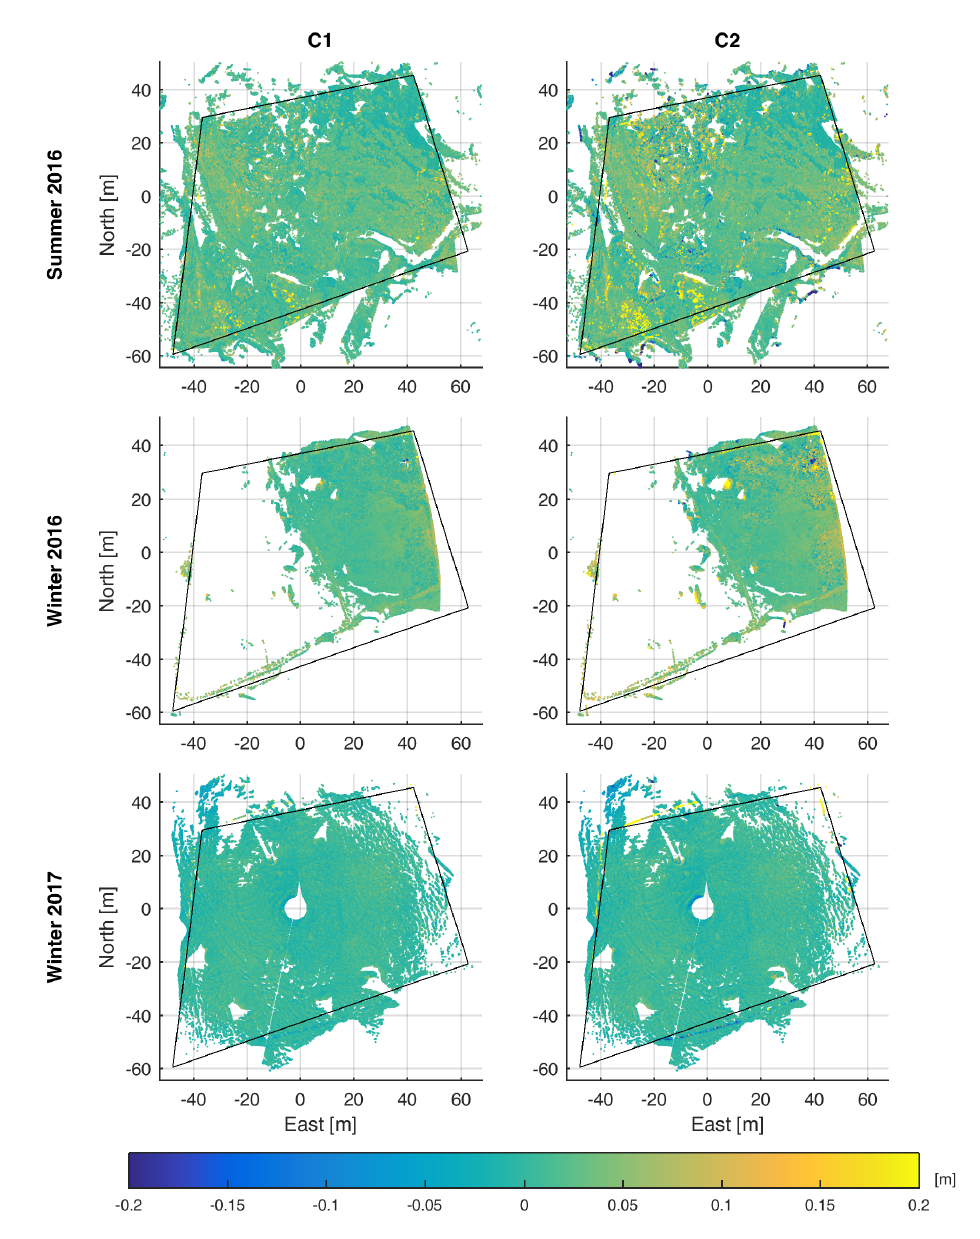
Figure 3. Height differences between the MultiStation (MS) dataset and the photogrammetric products for all surveys. C1 compares the MultiStation and the photogrammetric point clouds, whereas C2 compares the MultiStation point cloud with the DSM from UAS